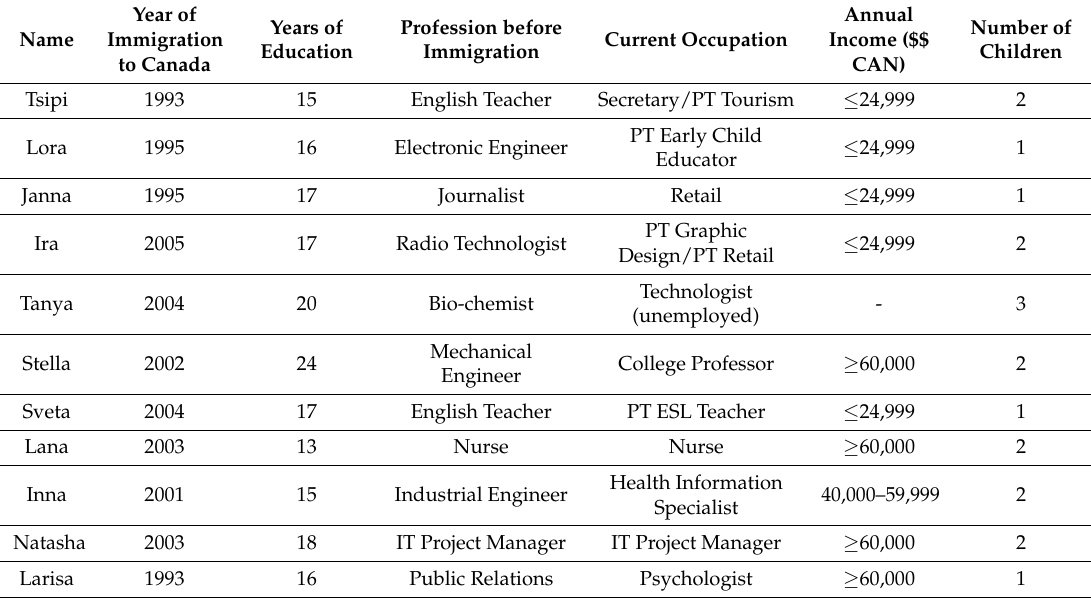
Table 1. Socio-demographic characteristics of study